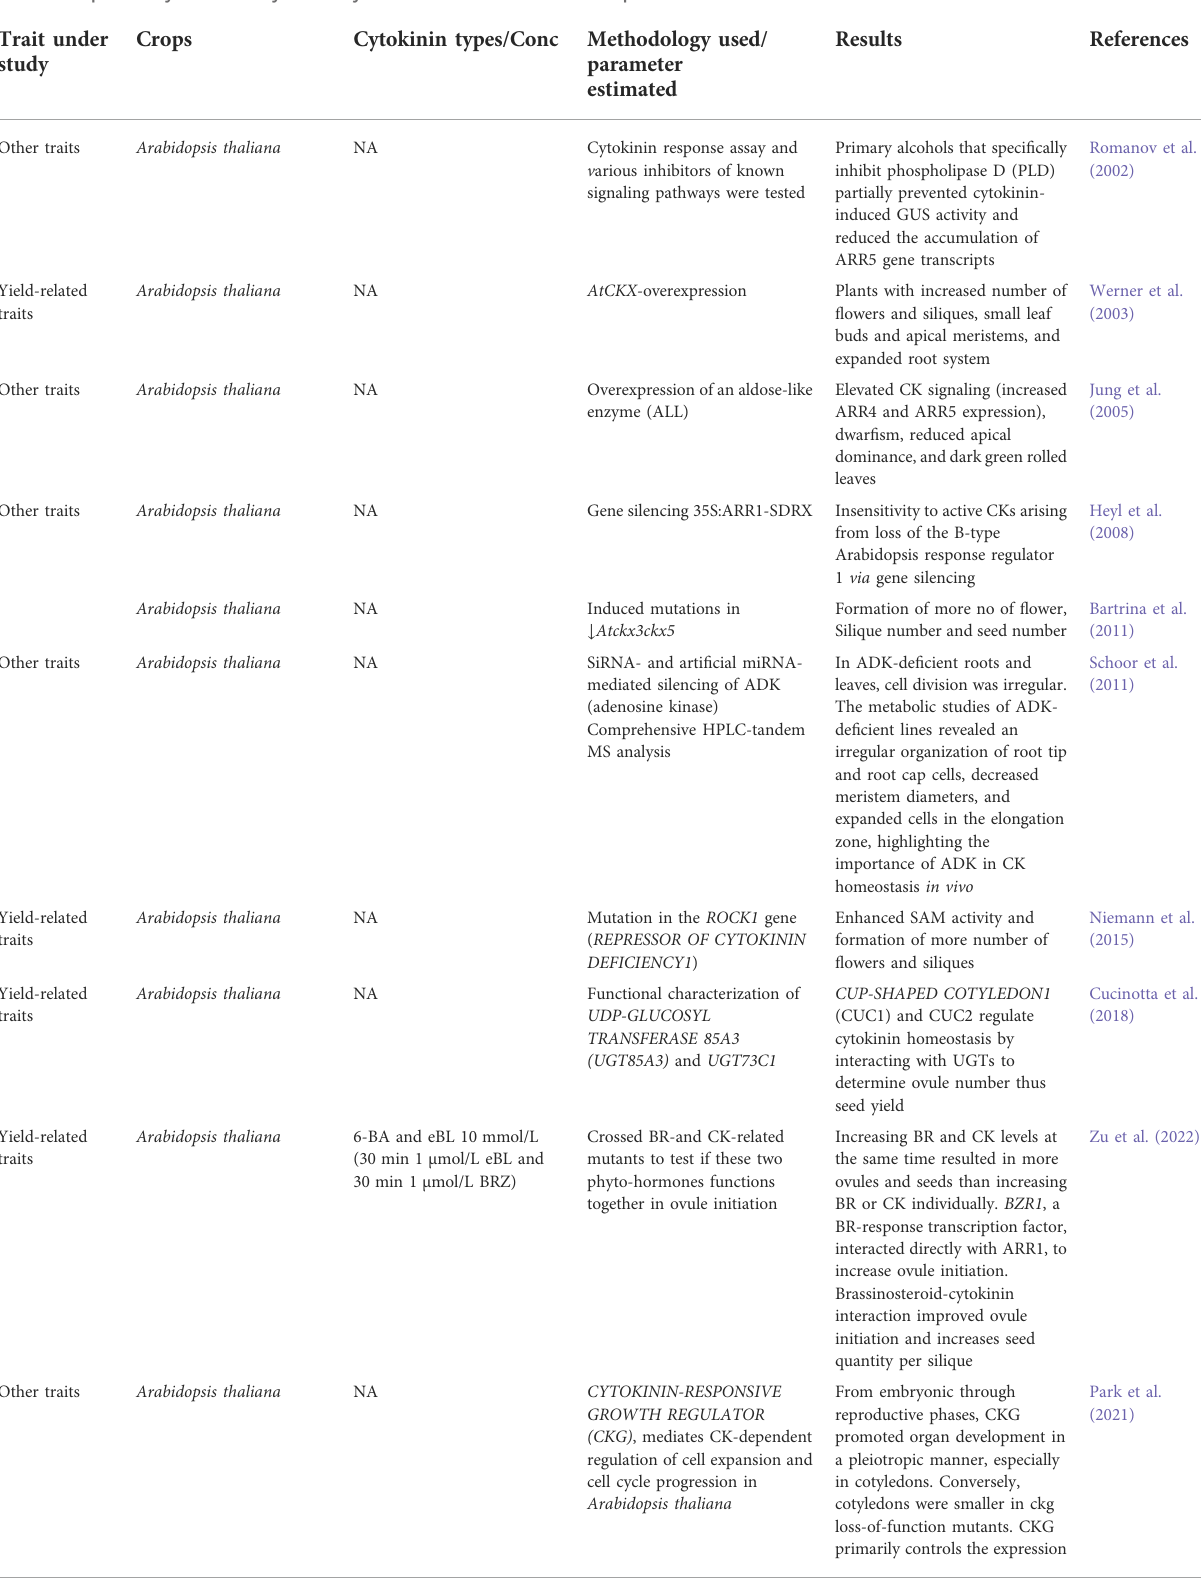
TABLE 1 Impact of cytokinins on yield and yield-related trait in oilseed and